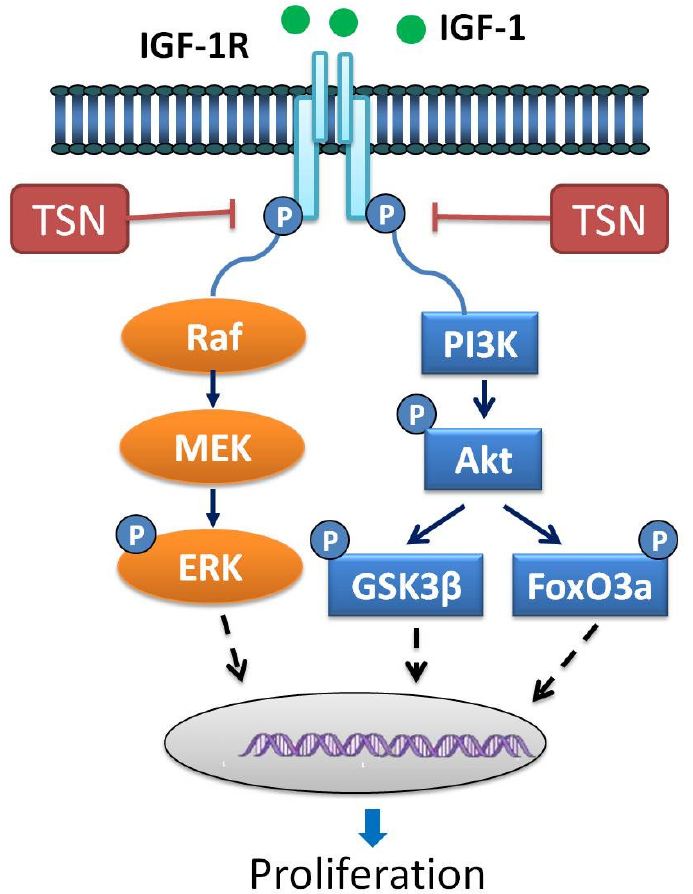
Figure 8. Schematic diagram of signaling mechanisms involved in the effects of TSN on cellular proliferation induced by IGF-1. IGF-1R is highly expressed in various cancer cells. When exposed to IGF-1, IGF-1R is auto-phosphorylated and activated. The activated IGF-1R subsequently regulates PI3K/Akt and MEK/MAPK signaling pathways, leading to cellular proliferation. TSN blocks the tyrosine phosphorylation of IGF-1R stimulated by IGF-1. As a consequence, TSN exerts its anti-proliferative effects by inhibiting IGF-1R and thus PI3K/Akt and MEK/MAPK signaling pathways.